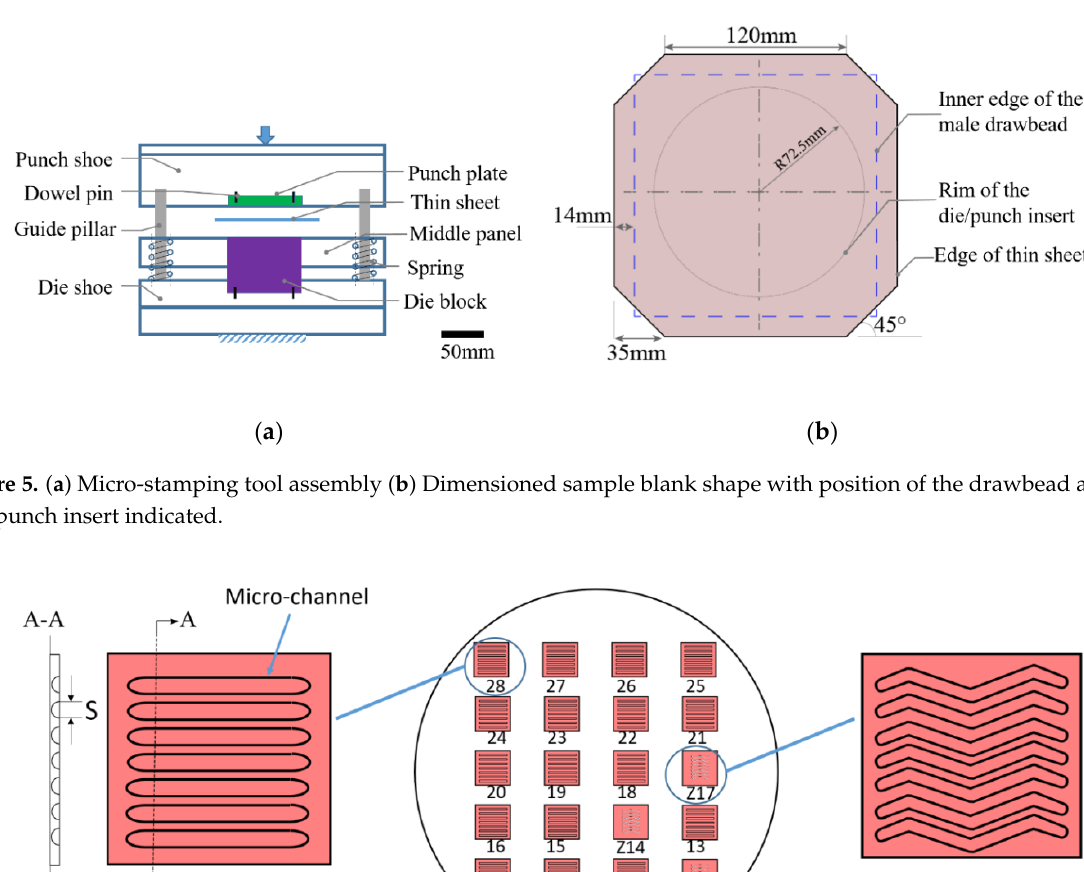
6 of 21 Figure 4. Schematic of the Erichsen cupping test (dimensions given in mm) (Reproduced with per- mission from [42]; Copyright Elsevier, 2020). In the tensile tests, a cross head speed of 0.06 mm/s was used while the punch speed in the Erichsen test was 0.2 mm/s. This gave similar strain rates and quasi-static forming conditions in both tests. To ensure near frictionless conditions between the punch and the sheet in the stretch forming test, a sandwich layer lubrication system was used. This con- sisted of the following layers: milk grease–LDPE foil–milk grease–PPE foil–milk grease– LDPE foil–milk grease. The PPE and the LDPE foils had a thickness of 0.35 mm and 0.055 mm respectively. In most cases this gave necking and material failure in the dome peak centre area. Forming strain was measured with a GOM Aramis camera system (ZEISS, Ober- kochen, Germany). For this, the sample surface was painted with a stochastic pattern. The ‘linear best-fit method’ described in [43] was used to determine the forming limit strains. 2.6. Micro-Stamping Trials The micro-stamping trials were limited to the three commercial 316L alloys and the